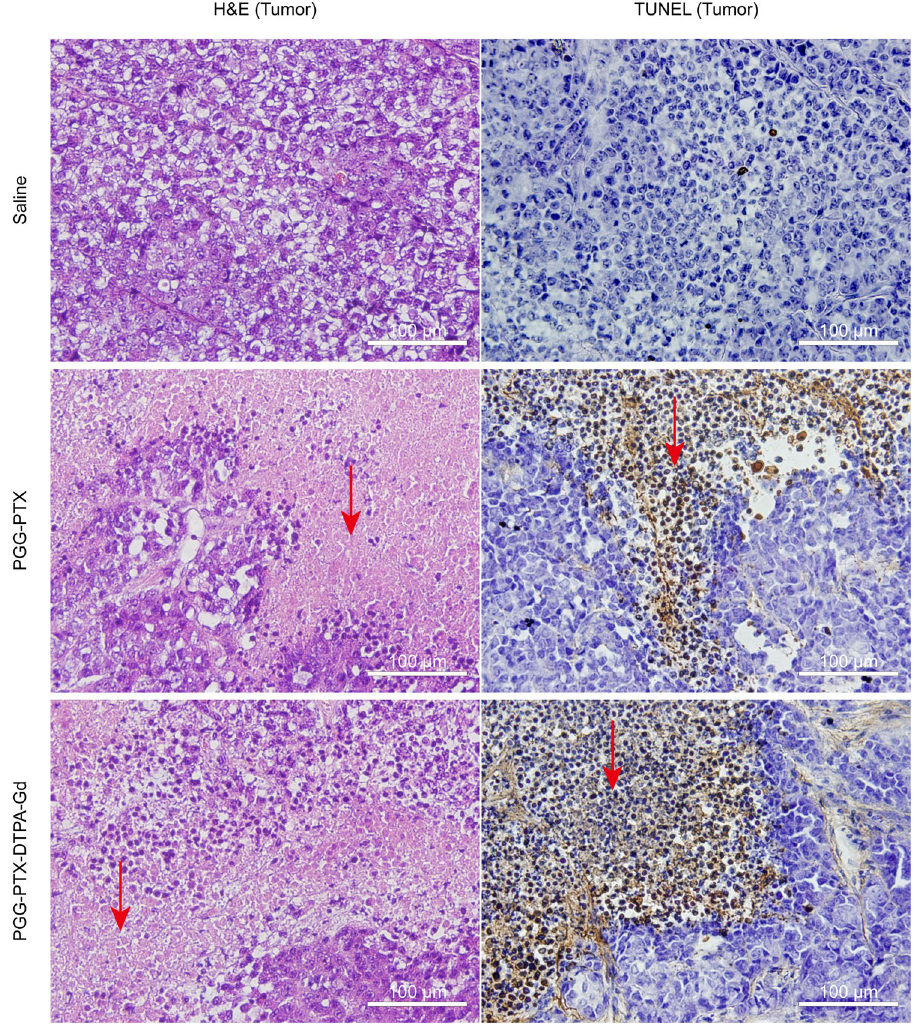
Figure 6. The H&E staining and TUNEL assay for tumor tissues harvested from the mice after the treatment (40x) with Saline (control), PGG-PTX NPs and PGG-PTX-DTPA-Gd NPs. The tumor tissue slides of the PGG-PTX-DTPA-Gd NPs and PGG-PTX NPs group showed a large amount of cell death (H&E staining) and significant apoptosis (TUNEL assay) compared with the Saline group (the red